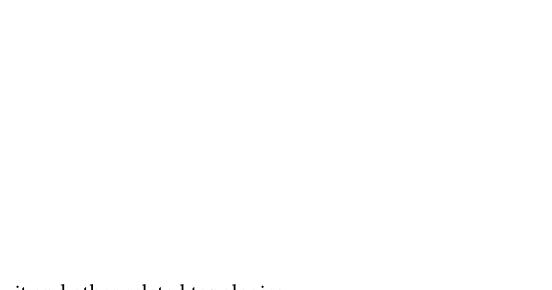
Table 2. Measured efficiency of the proposed circuit and other related topologies.